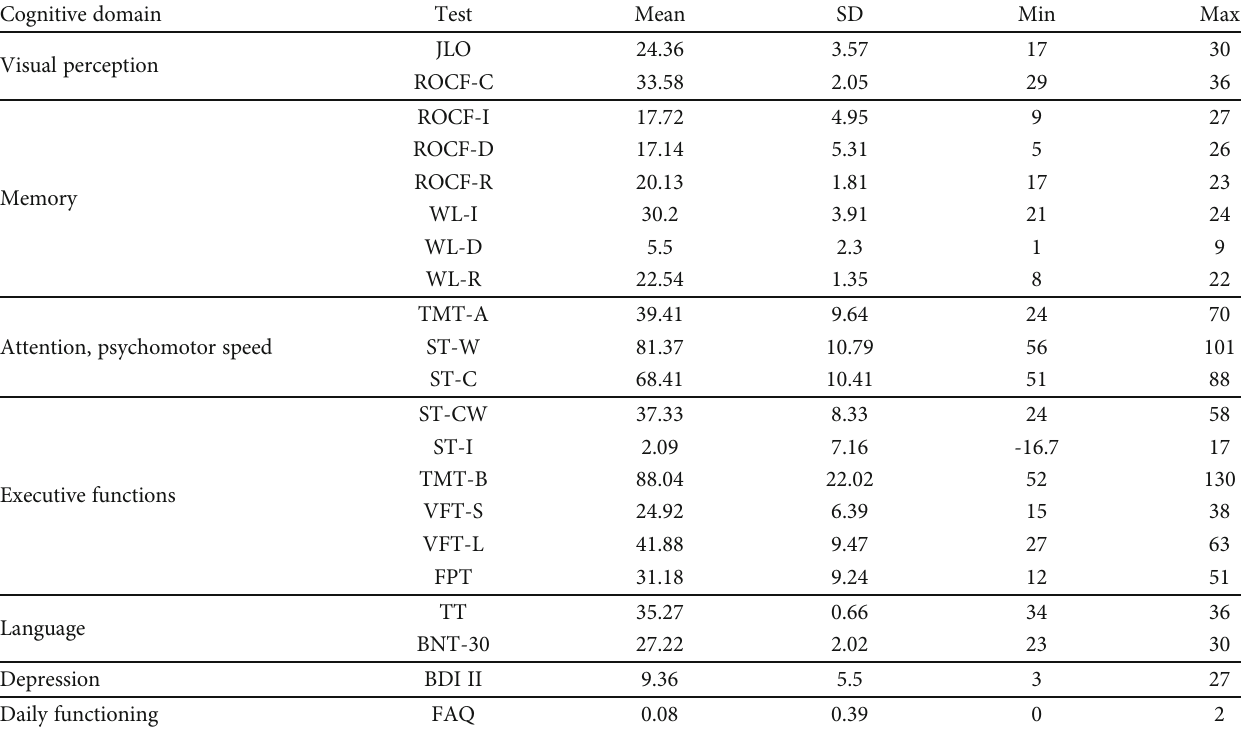
Table 1: Neuropsychological characteristics of the study group, N = 25 .